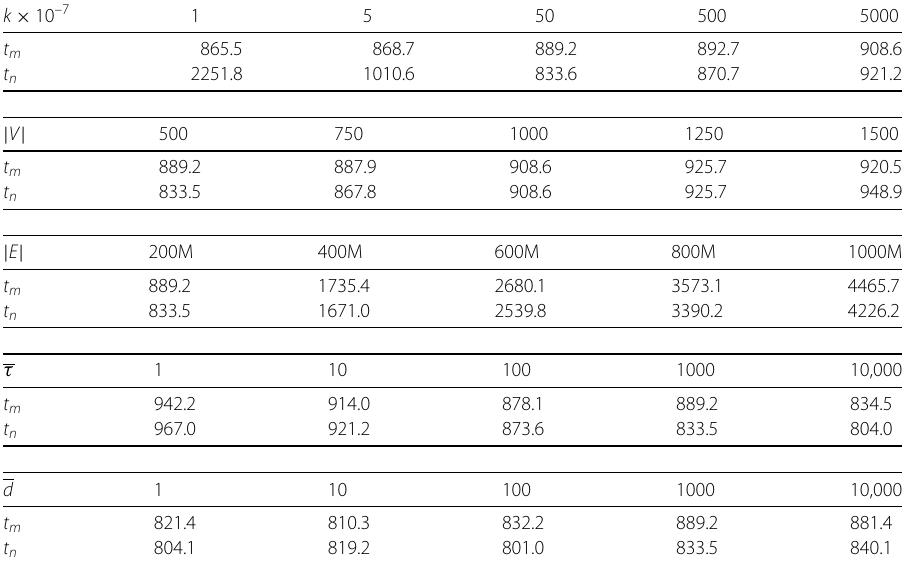
Table 6 Generation time in both monotonic (denoted t m ) and non-monotonic (denoted t n ) networks with respect to schemas (secs). In most cases, the variation of time is monotonic. The only exception is k -varying t n , which first decreases and then